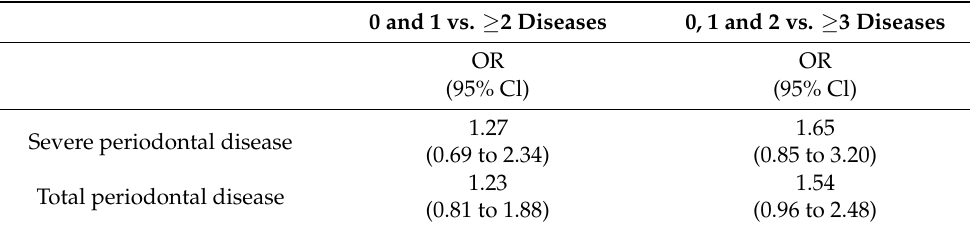
Table 5. Multimorbidity in association with the periodontal disease status. 0 and 1 vs. ≥ 2 Diseases